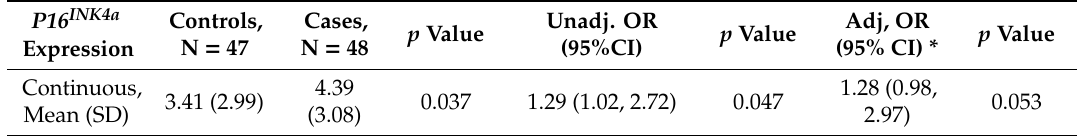
Table 4. Validation of the association using pre-diagnostic